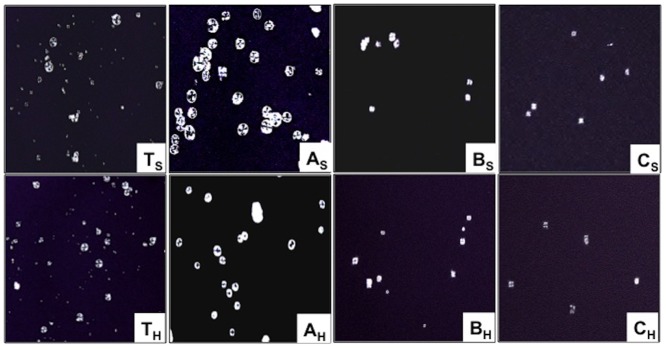
Birefringence images of starch granules.